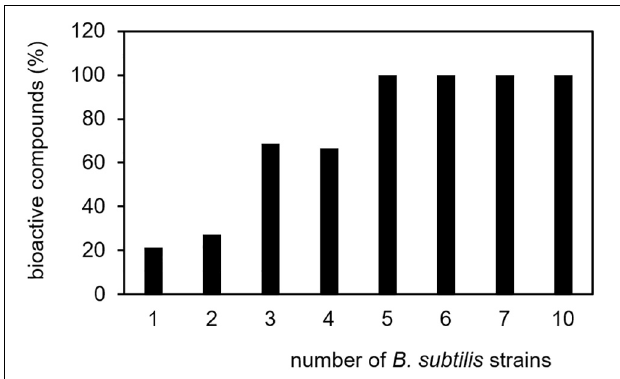
FIGURE 4 | Specificity of biological-active volatile secondary metabolites. Volatile secondary metabolites emitted by 26 B. subtilis isolates were summarized from 20 original scientific publication (see Table 1 ). Biological-active compounds were related to the total number of volatiles and the number of emitting B. subtilis